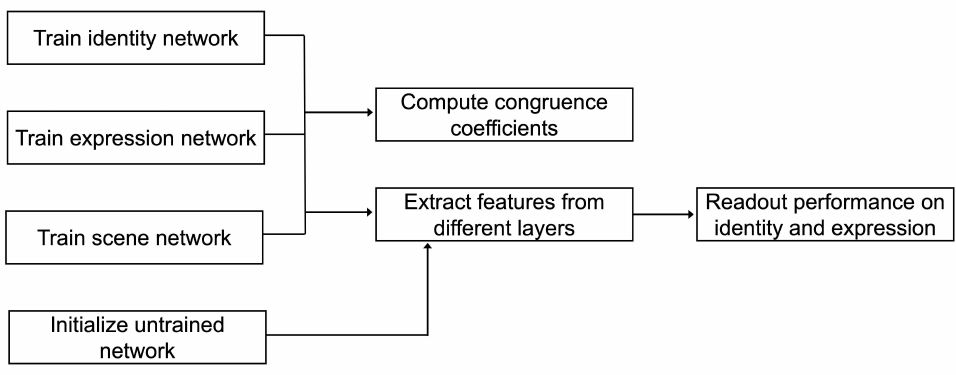
Figure 3. Analysis flowchart. An overview of the analysis steps